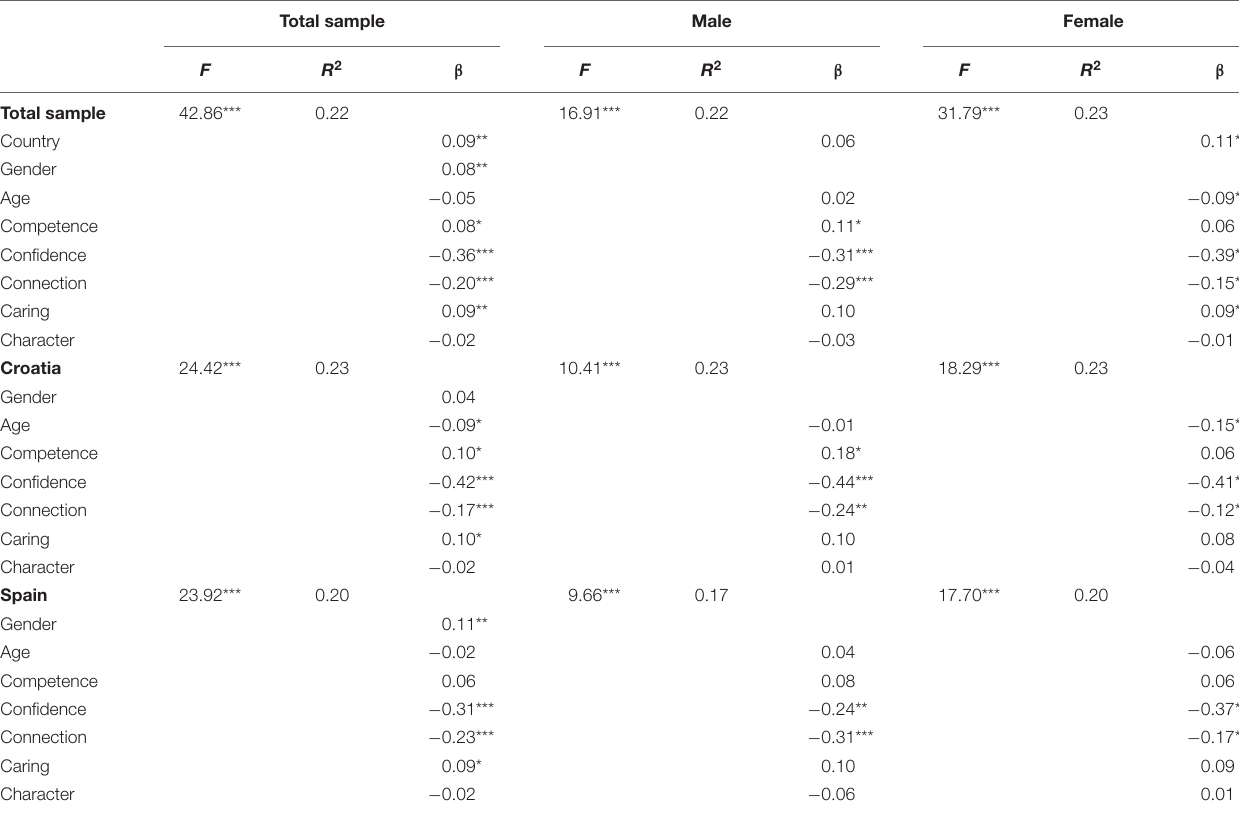
TABLE 4 | Hierarchical regression analysis to examine overall score in depression by demographics and